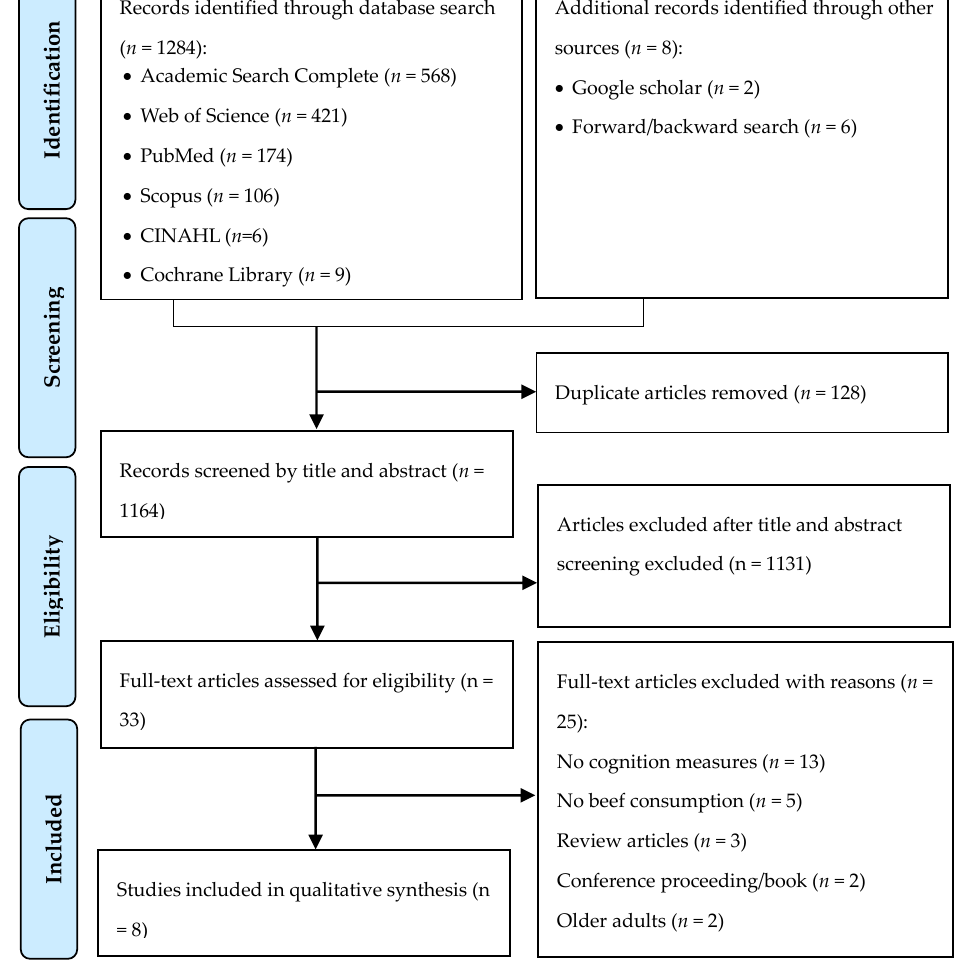
Figure 1. Study selection